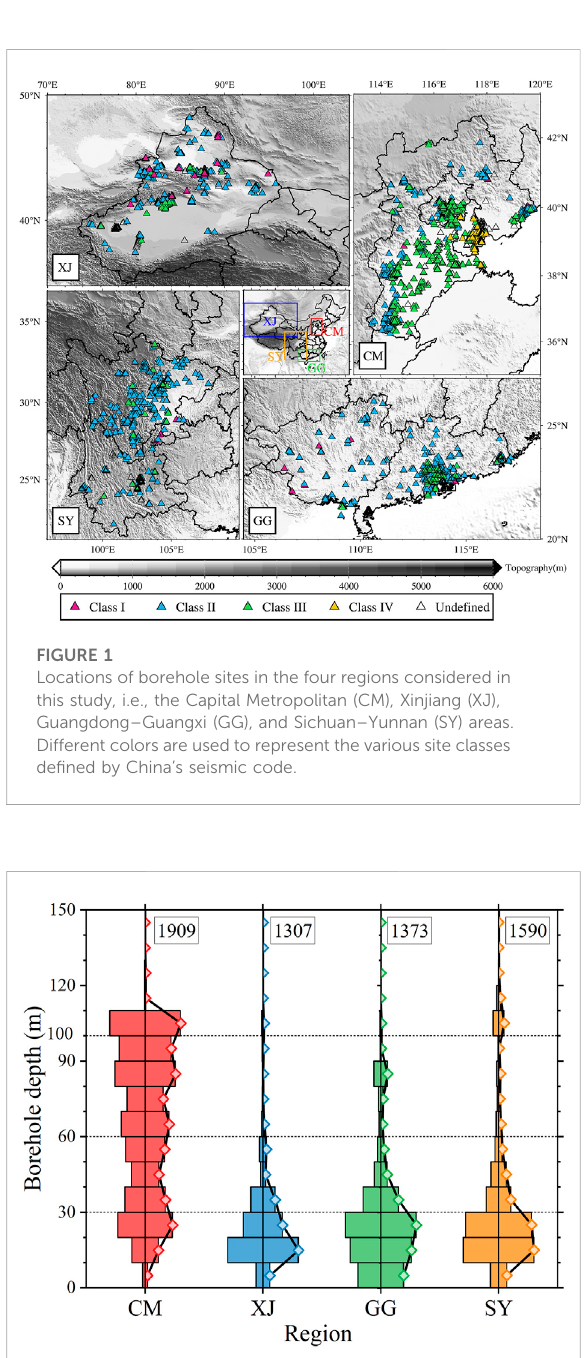
FIGURE 2 Histograms of the distribution of borehole depth at sites in CM, XJ, GG, and SY. The numbers within the box represent the total number of the sites in different regions, the rectangles with different colors stand for the number of sites in each bin, and the polylines with squares represent the proportion of the number of sites in each bin to the